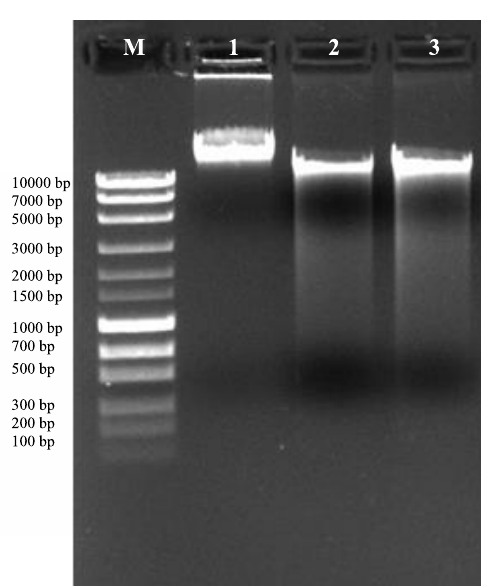
Fig. 7. 16S rRNA PCR gel image of isolated strains showing amplicon size of around 1600 bp (M-1Kb DNA ladder, 1- HYJE003 and 2- HYJE005 )